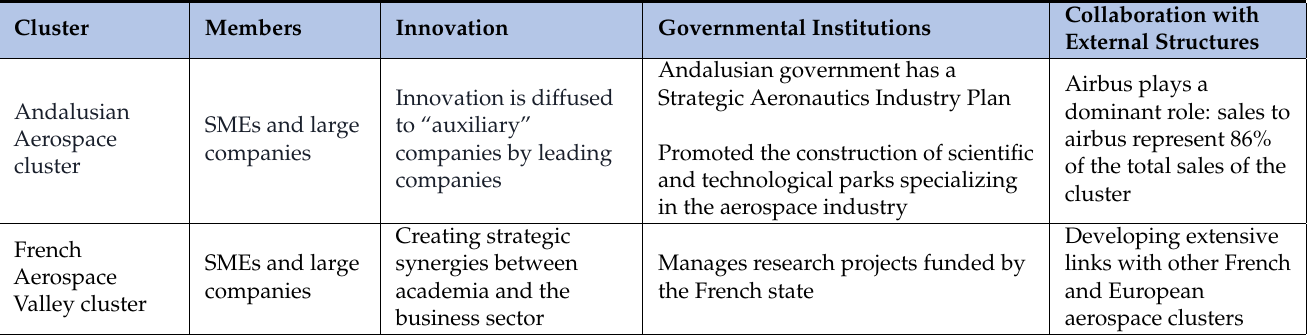
Table 4. Characteristics of the clusters under